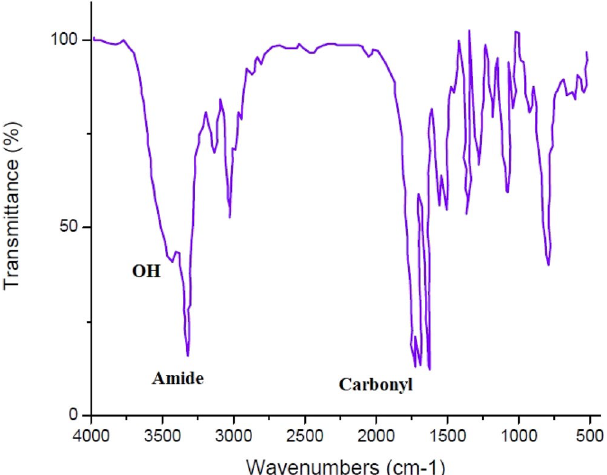
Figure 10. IR spectrum of PNIPAAM produced in SC-CO 2 .